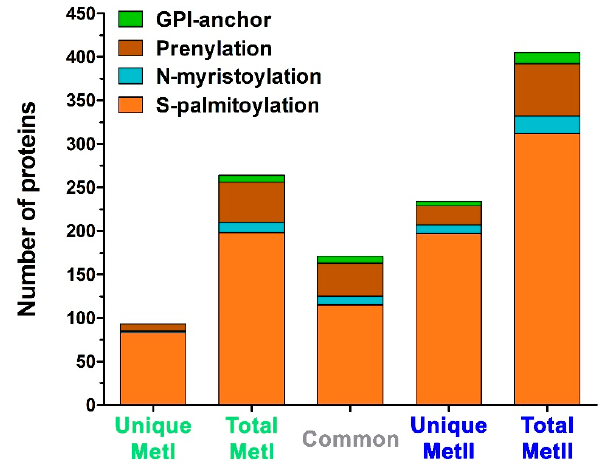
Figure 3. Proteins with an annotated lipid modification identified in mast cell lipid rafts isolated using Method I or Method II. Databases used: PhosphoSitePlus, SwissPalm, MYRbase, PRENbase, and PredGPI.